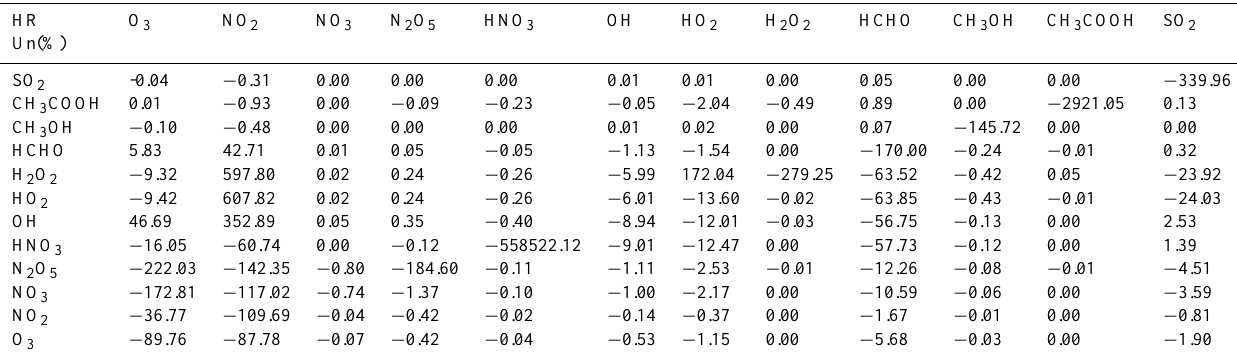
Table D1. The uncertainties computed by normalizing the absolute differences by the tracer mixing ratios calculated with the “Best Guess” coefficients. Columns are different heterogeneous removal reactions (HR) and rows are uncertainties in percent (Un(%)).